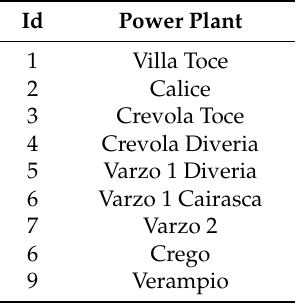
Figure 1. The Toce watershed extracted from the digital elevation model showing the locations of the automatic weather and hydrometric stations, reservoirs, power plants, and the area included in the analysis of power production. Table 1. Power plants show in Figure 1.